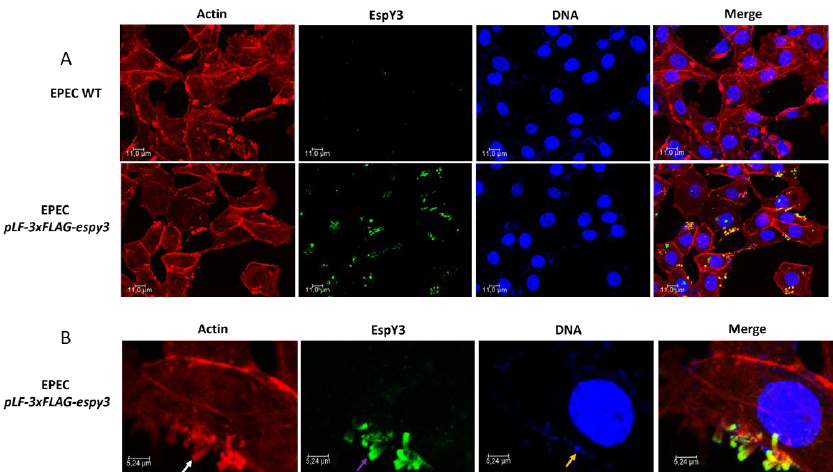
Figure 3. Subcellular localization of EspY3. ( A ) Caco-2 cells were infected with EPEC wildtype (WT) and EPEC pLF-3xFLAG-espy3 (MOI 5). The polymerized cellular actin was stained with Rhodamine-phalloidin (Red), the eukaryotic nuclei and bacterial DNA with TO-PRO-3 (Blue), and EspY3 protein was detected using anti-FLAG mouse specific antibodies and Alexa 488-conjugated goat anti-mouse IgG as secondary antibody (Green) (ZOOM 1). ( B ) The white arrow shows the polymerized cellular actin (pedestals), the purple arrow shows the translocated EspY3, and the blue arrow shows the presence of EPEC on the pedestal lesion. The yellow color in the last image (merge between the red color of the pedestals and the green color of the EspY3) represents the co-localization of EspY3 with the polymerized actin in the pedestals (ZOOM 3). The cells were observed under a confocal laser scanning microscopy (40×, 1.5 AN objective-Leica TCSSP5-CICVyA-INTA).